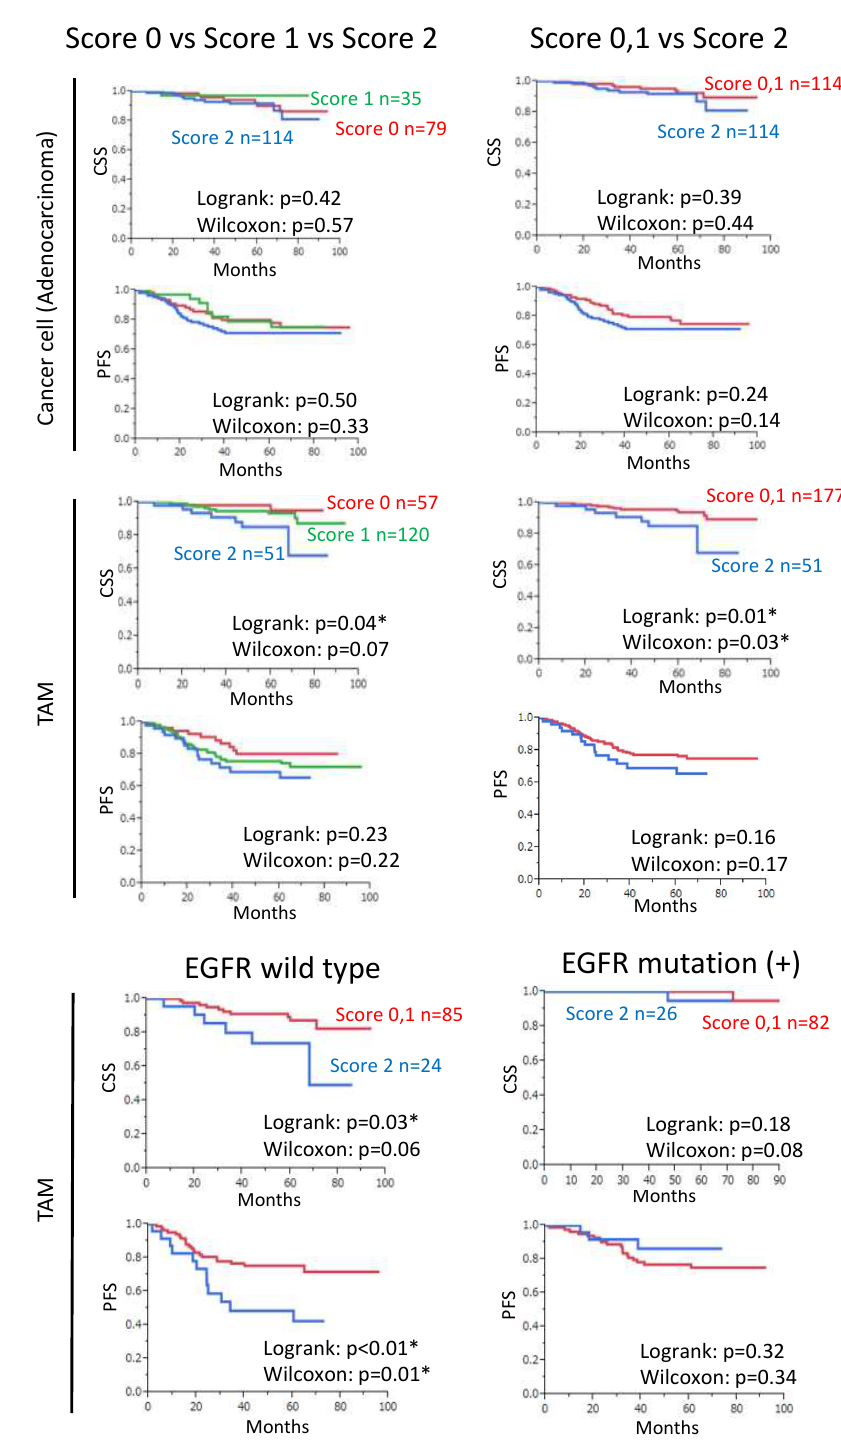
Figure 3. Kaplan–Meier survival analyses according to the SPP1 score in lung adenocarcinoma. ( A ) Kaplan–Meier analyses of the CSS and PFS according to the SPP1 score in cancer cells or TAMs. The graphs on the left show the survival curves for score 0, score 1, and score 2. The graphs on the right show the survival curves for scores 0 and 1 combined, and score 2. ( B ) Kaplan–Meier analysis of the CSS and PFS according to the SPP1 score in TAMs when divided into EGFR-wild-type and EGFR-mutation-positive groups. *: statistically significant, p value <